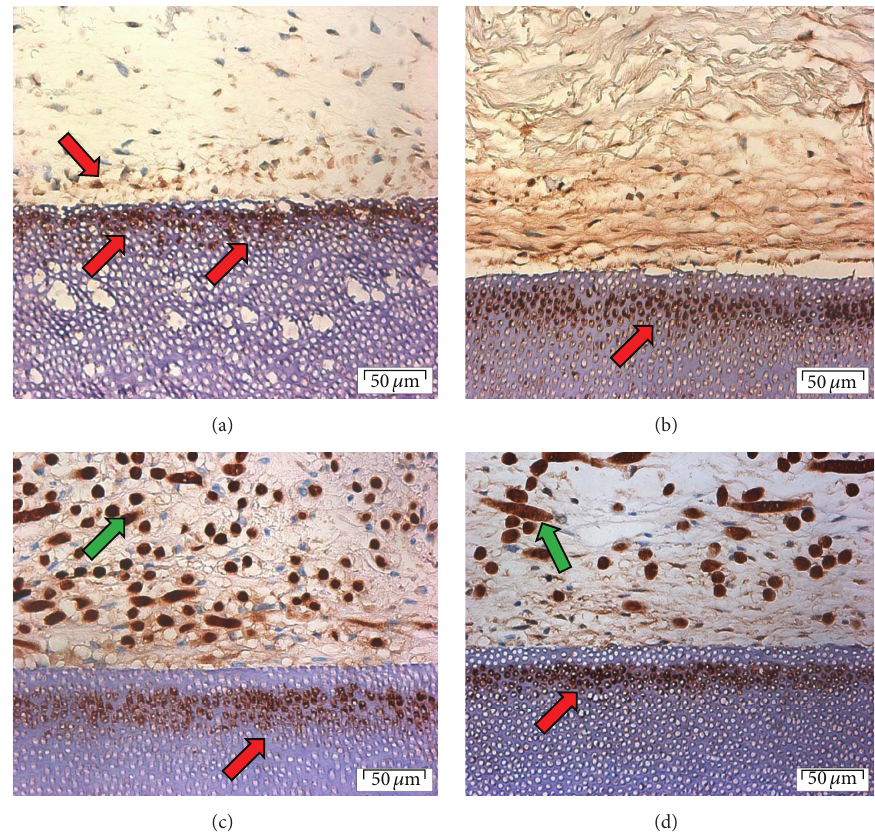
Figure 3: Osteocalcin expression in (a) collagen-spheroids-dentin, (b) collagen monolayer fibroblast-dentin, (c) PGA-spheroid-dentin, and (d) PGA-monolayer fibroblast-dentin cultures after 20 days. Original magnification × 40 (scale bar = 50 𝜇 m). Green arrows show nonspecific